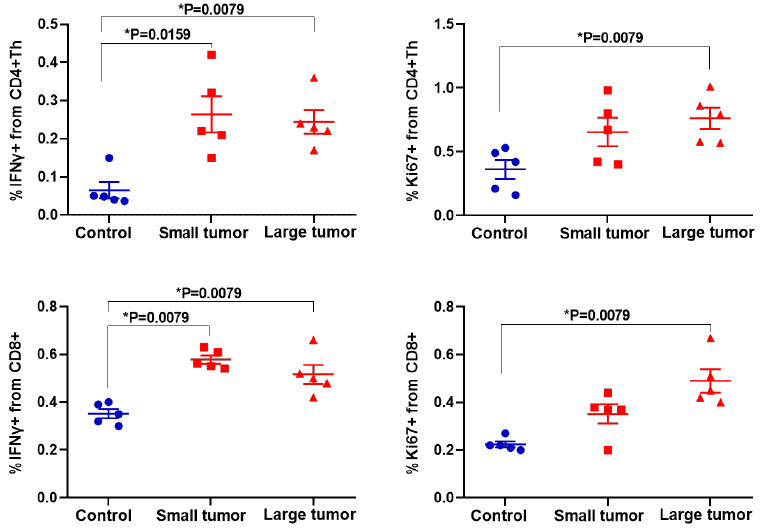
Figure 5. Expression of IFN γ and Ki67 in fixed CD4+ Th and CD8+ T-cells. Scatter dot plots display the measurements for individual animals (dots) and the mean and SEM (horizontal lines).